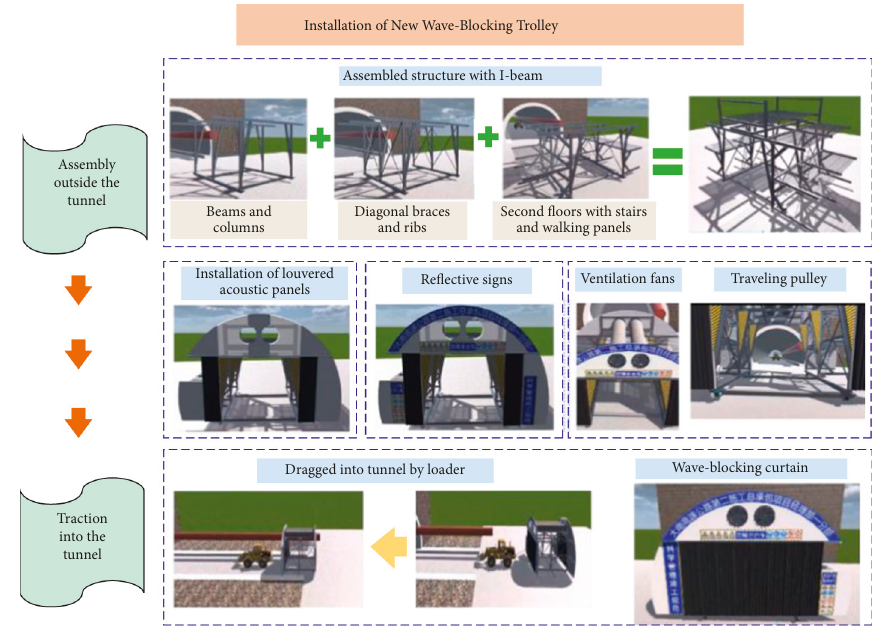
Figure 5: Installation of NWBT.